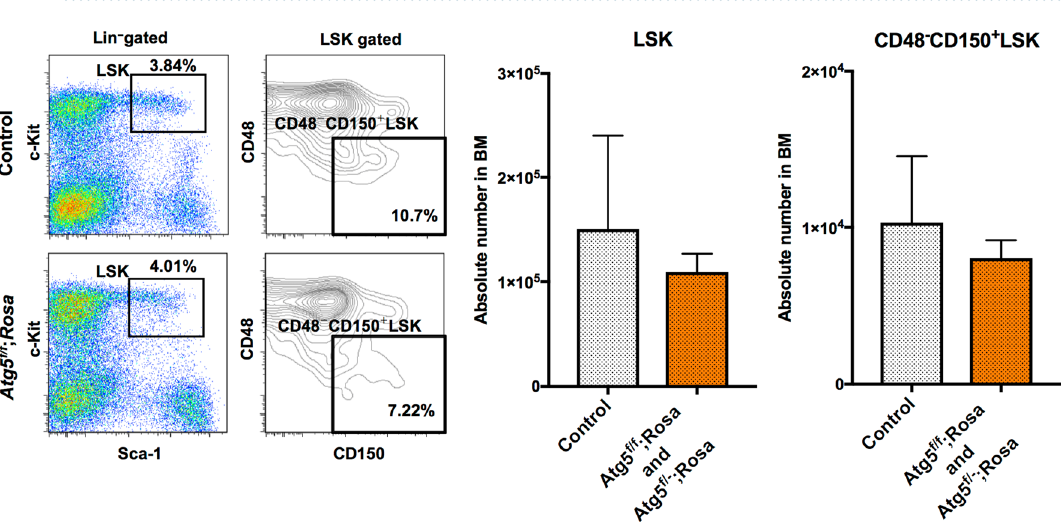
Figure 3. HSC population in control ( Atg5 f / w ; Rosa and Atg5 w / w ; Rosa ), and Atg5 f / f ; Rosa and Atg5 f / − ; Rosa mice at 8–12 months after tamoxifen administration at P5. Left panel shows a representative flow cytometric plot of LSK (Lin − c-Kit + Sca1 + ) cells and CD48 − CD150 + LSK cells in three independent experiments. Right panel shows absolute numbers of LSK and CD48 − CD150 + LSK cells. Data are the mean ± SD (n =